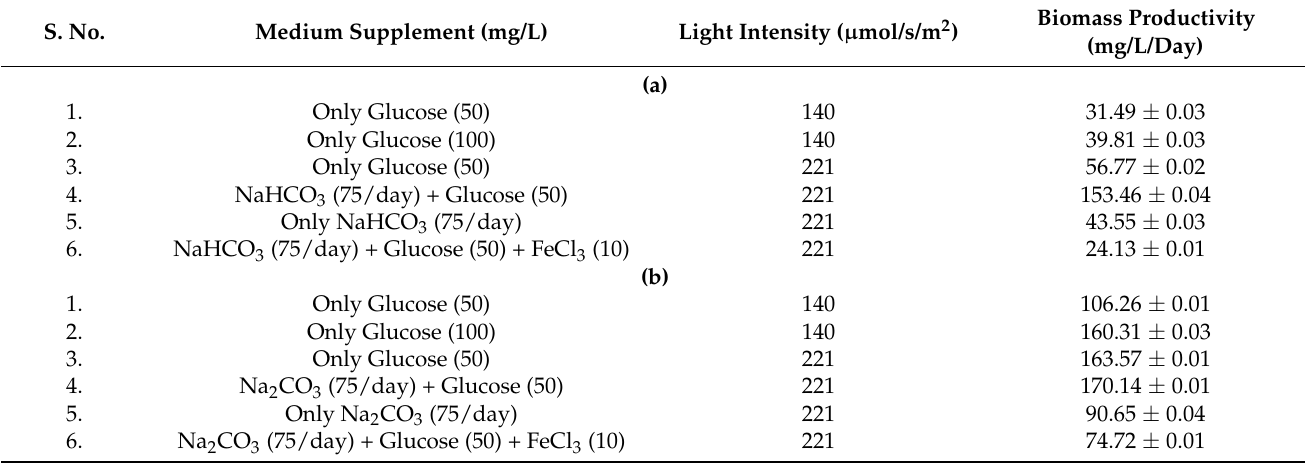
Table 3. Change in cell density of (a) Chlorella sorokiniana 1 (isolated from BG-11 at pH-9); (b) Chlorella sorokiniana 2 (isolated from Knop’s medium at pH-9), grown in synthetic hydrolysate under different light intensities and carbon sources. S.